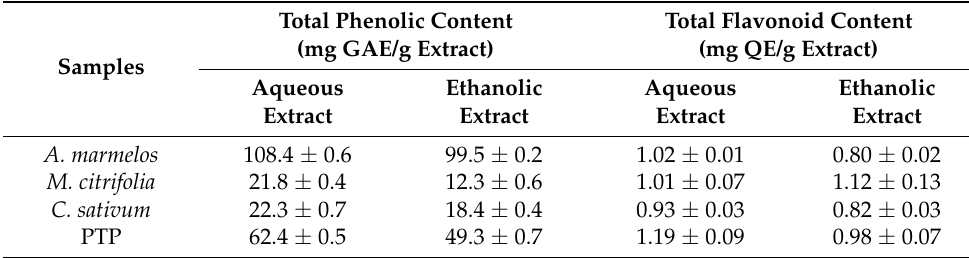
Table 1. Total phenolic content (mg GAE/g extract) and flavonoid content (mg QE/g extract).